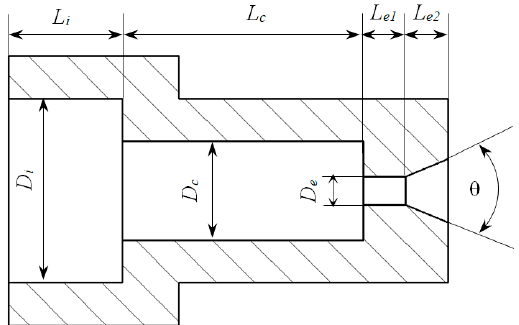
Figure 3. Profile of organ-pipe nozzle.